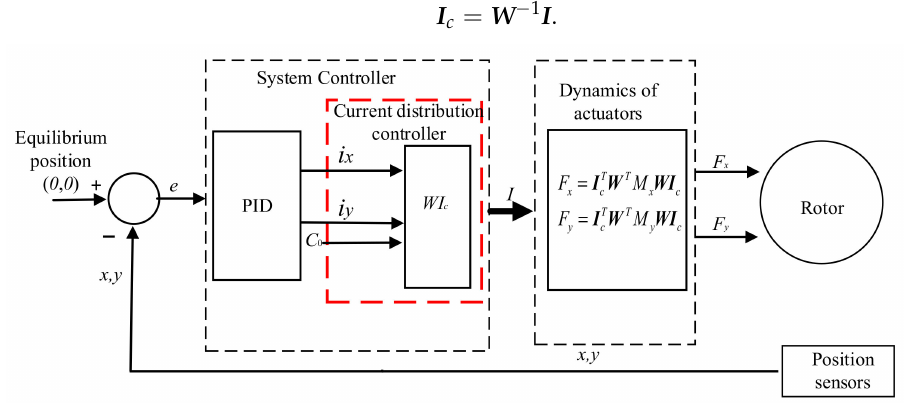
Figure 4. Closed-loop control strategy in magnetic bearings with redundant structures.